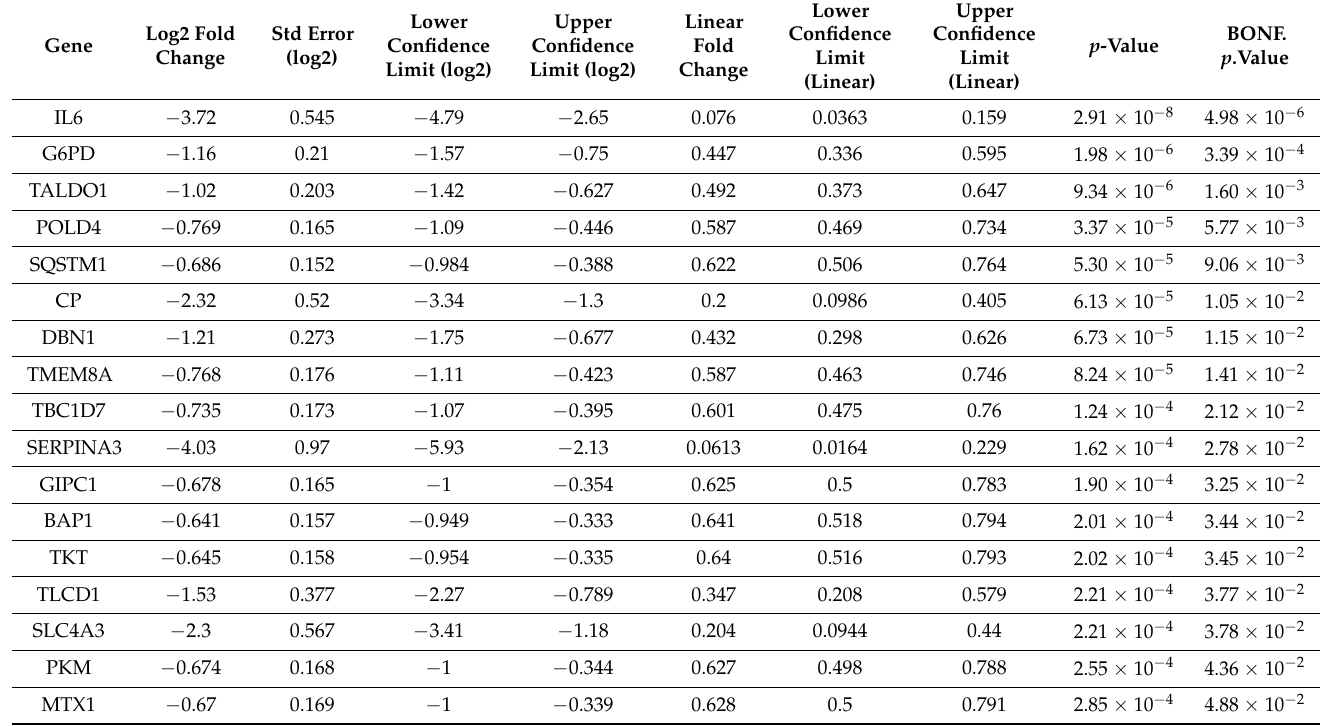
Table 2. List of differentially expressed genes between recurrence-free survival (RFS) of <1 y and RFS of >5